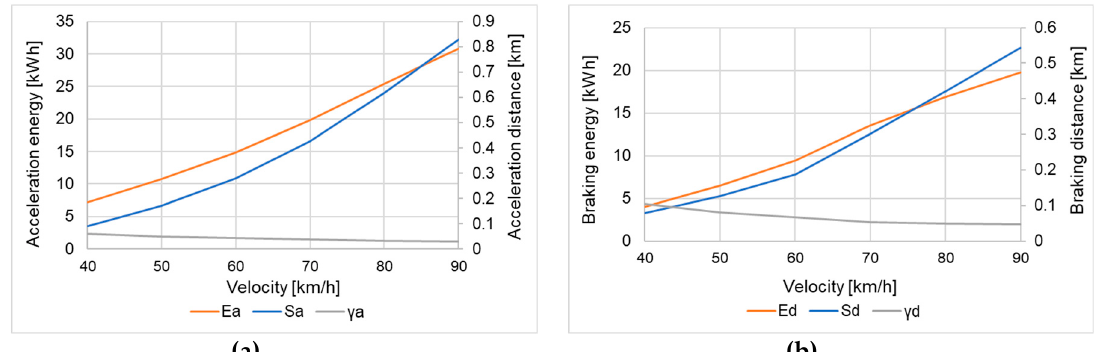
(b) Figure 7. Simulation results for three sizes of ESD: ( a ) φ —power optimization parameter, ( b ) ∂— energy optimization parameter. From Figure 7 it may be observed that the power and energy optimization parameters are